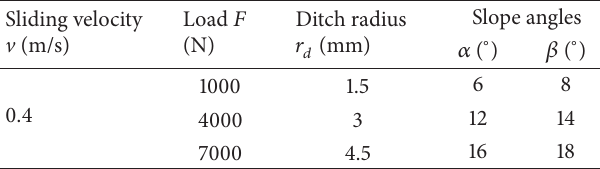
Table 4: Input parameters for tread block and